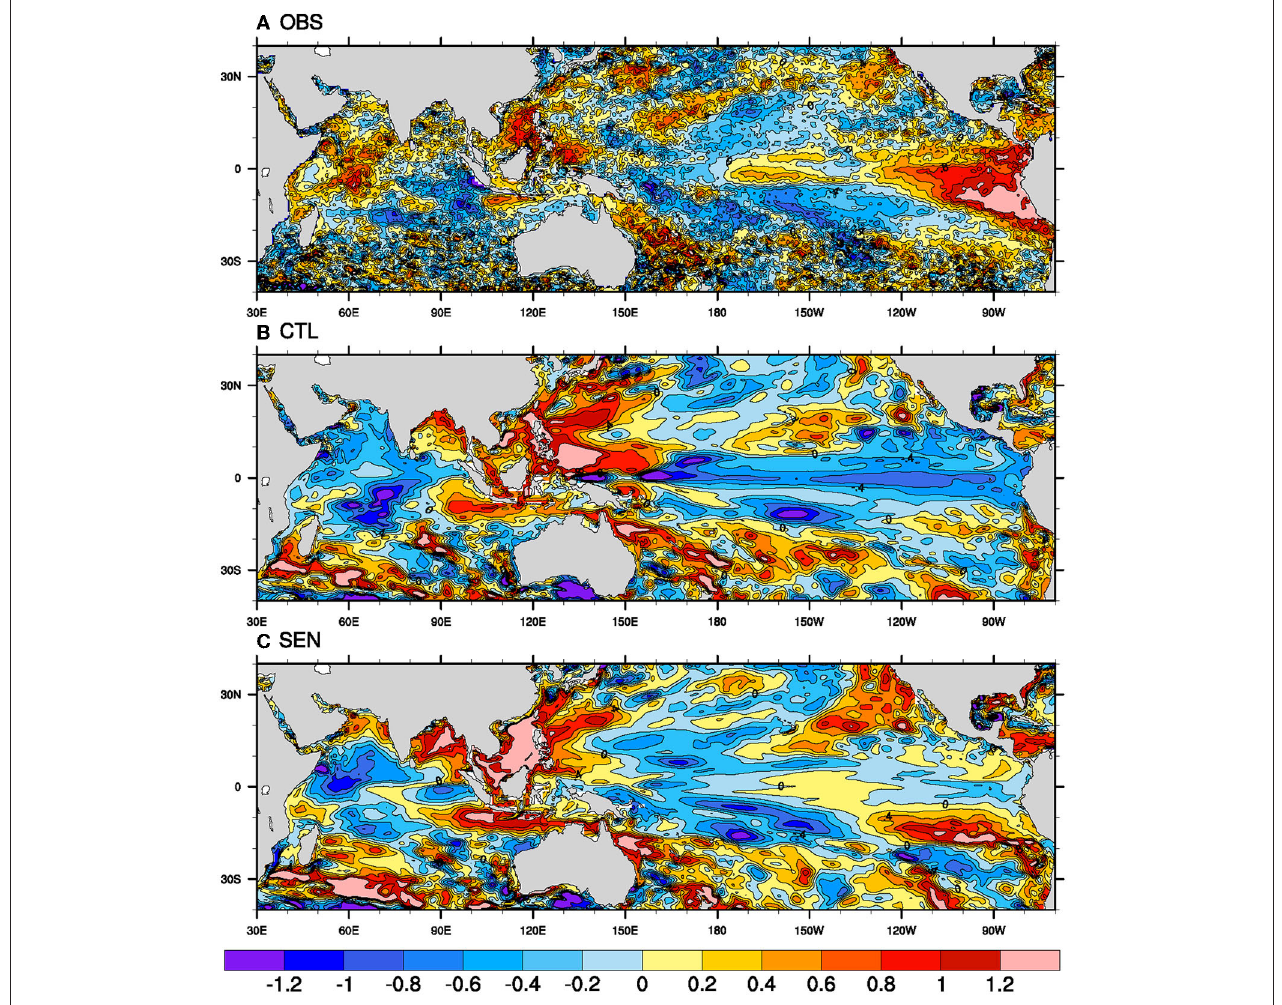
FIGURE 11 | Skewness of de-trended SST anomaly during JJAS in (A) observation, (B) CTL run, and (C) SEN run for the period of 1981–2017.